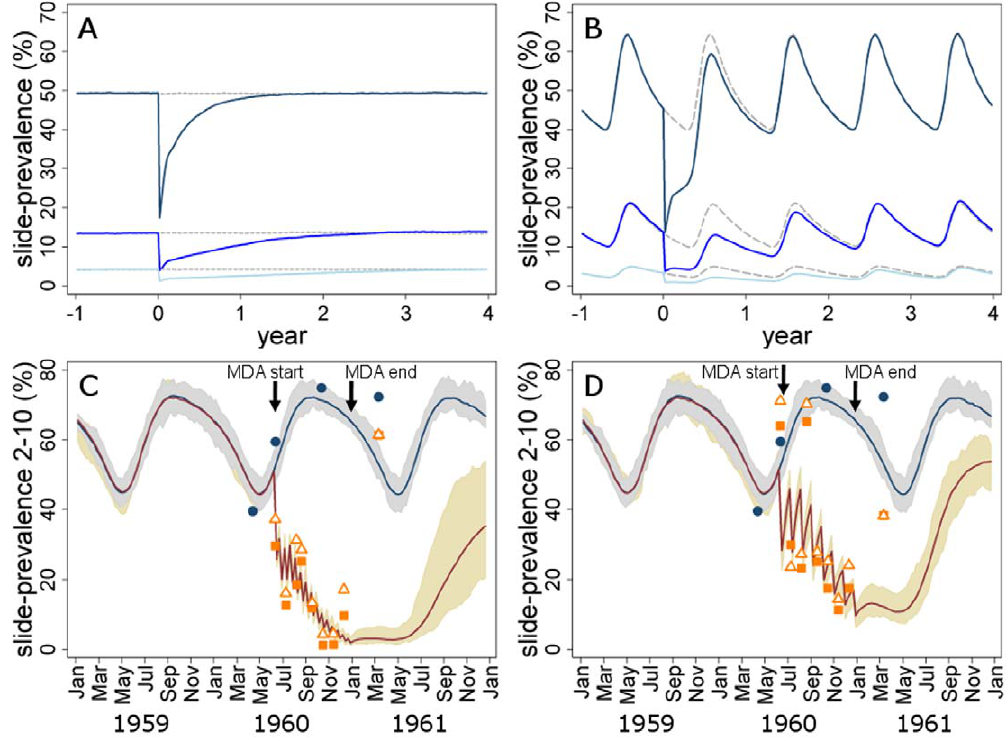
Figure 1. Rebound in transmission following mass treatment & comparison with trial data. (A) & (B) Typical MDA model output over time in scenarios of (A) non-seasonal and (B) seasonal transmission with different baseline transmission intensities: high: baseline average annual slide- prevalence=50% (dark blue); medium: baseline slide-prevalence=15% (mid-blue); low: baseline slide-prevalence=5% (light blue). A single round of MDA is carried out at year 0 at 80% coverage (actual coverage is lower due to exclusion of pregnant women). Gray dashed lines indicate predicted prevalence in the absence of MDA. (C) & (D) Comparison of model predictions with trial data [26]: slide-prevalence in 2–10 year olds in control villages and intervention villages with MDA carried out (C) every 14 days or (D) every 28 days. Blue line=average model-predicted values in control villages; dark red line=model predicted value in MDA villages; shaded areas=range of 20 simulations of control and MDA prevalence; blue circles=prevalence data in control villages; orange triangles=prevalence data from chloroquine-treated individuals in MDA villages; orange squares=prevalence data from amodiaquine-treated individuals in MDA villages.